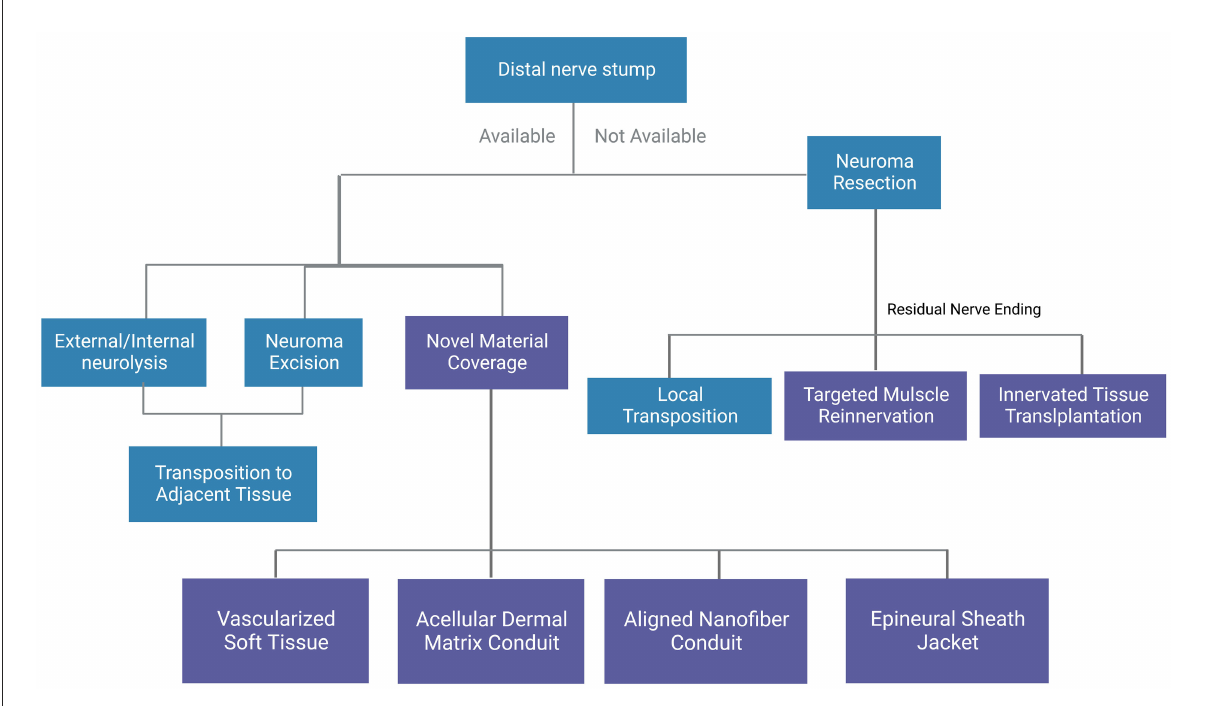
FIGURE3 A general summary of surgical methods for traumatic neuromas. Blue boxes indicate conventional methods and purple boxes indicate novel